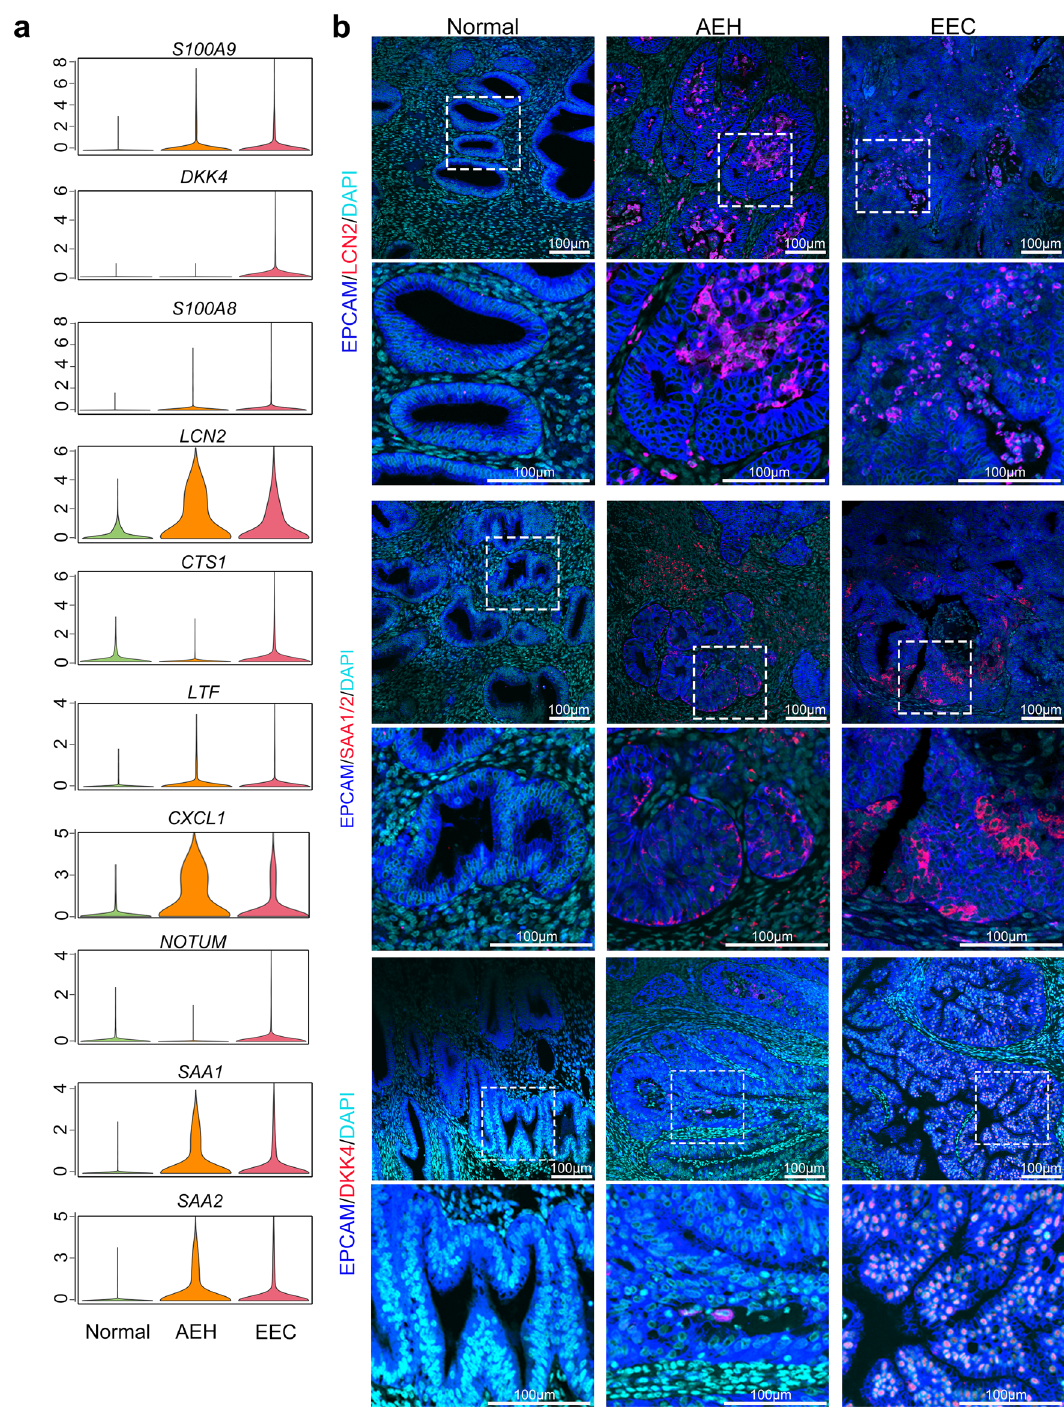
Fig. 4 | Identi fi cation of oncogenic subpopulation on clinical specimens. a Violin plots showing mean expression of genes which are screened between EEC and normal samples, in different endometrial pathology stages (Normal, AEH and EEC). Candidate genes were chosen according to the third quantile of normalized